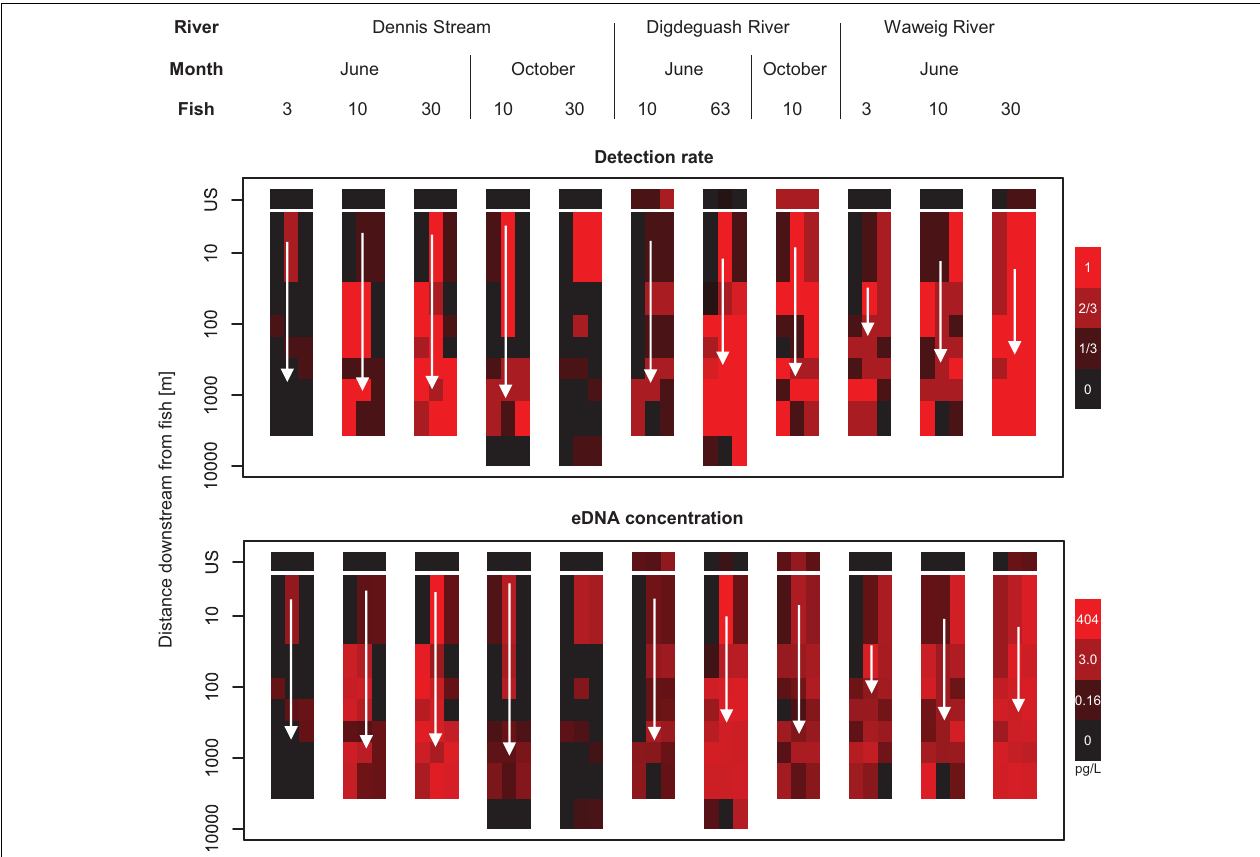
FIGURE 2 | Salmon eDNA detection rates and quantities for bankside and midstream samples in three New Brunswick streams. White arrows indicate average stream velocity, which ranged from 0.15 to 0.53 m/s. Velocity data was not available for the 30 fish treatment in Dennis Stream in October. Detection rate is defined as the number of qPCR replicates where salmon DNA was detected. US, upstream control samples (see section “Materials and